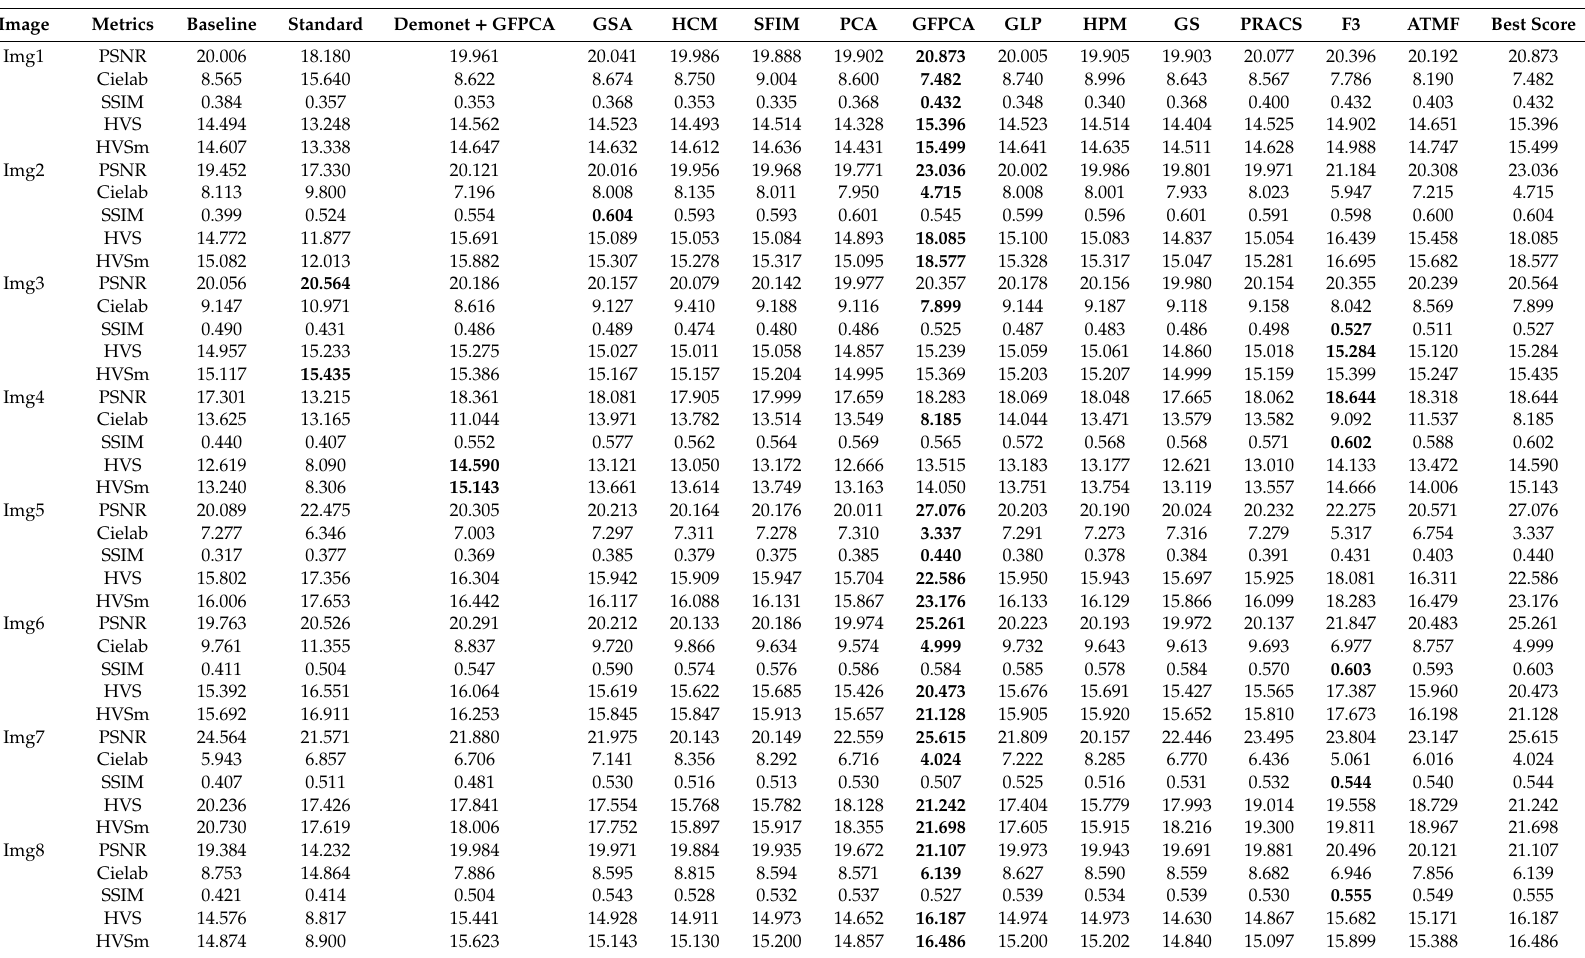
Table A6. Performance metrics of 14 algorithms at 20 dBs SNR. Bold numbers indicate the best performing methods in each row. Red numbers indicate those methods used in F3 and those red and green numbers indicate those methods used in